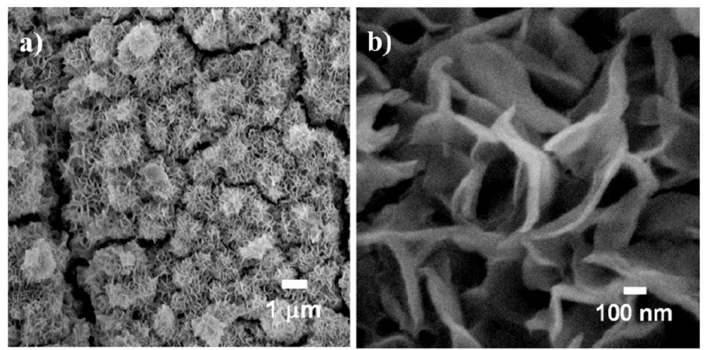
Figure 2. SEM image at di ff erent magnifications of magnetite nanosheets. Adapted from [100] with permission from American Chemical Society,